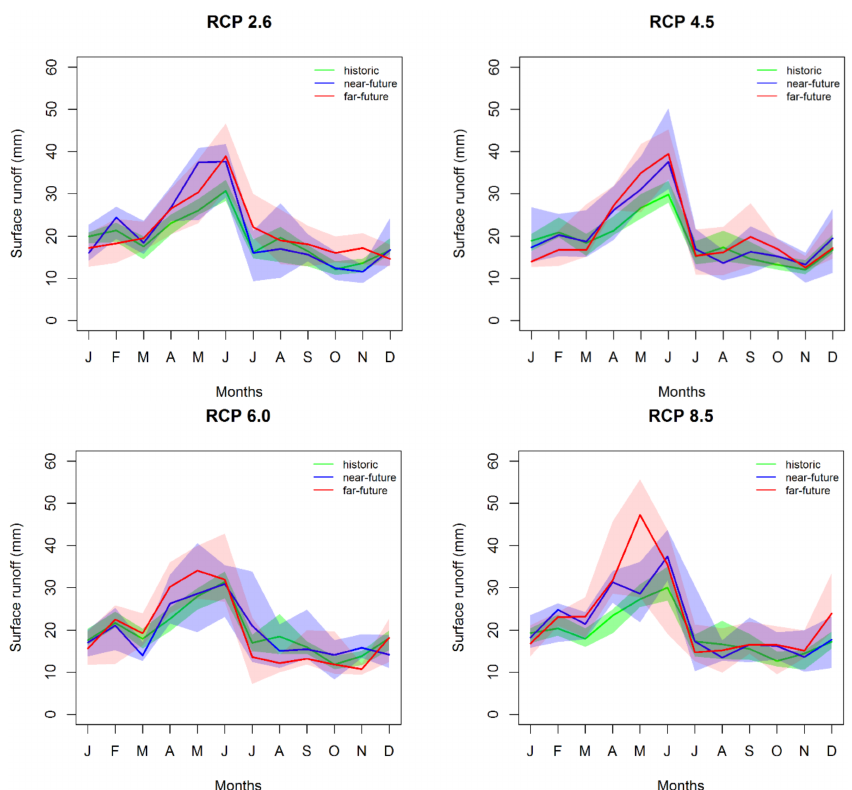
Figure 9. Monthly ensemble median and quartile of downscaled monthly surface runoff for historic and future projections in Goodwater Creek Experimental Watershed. The median is represented by the solid line with Q1 represented by the lower bound of the shaded region and Q3 represented by the upper bound of the shaded region.